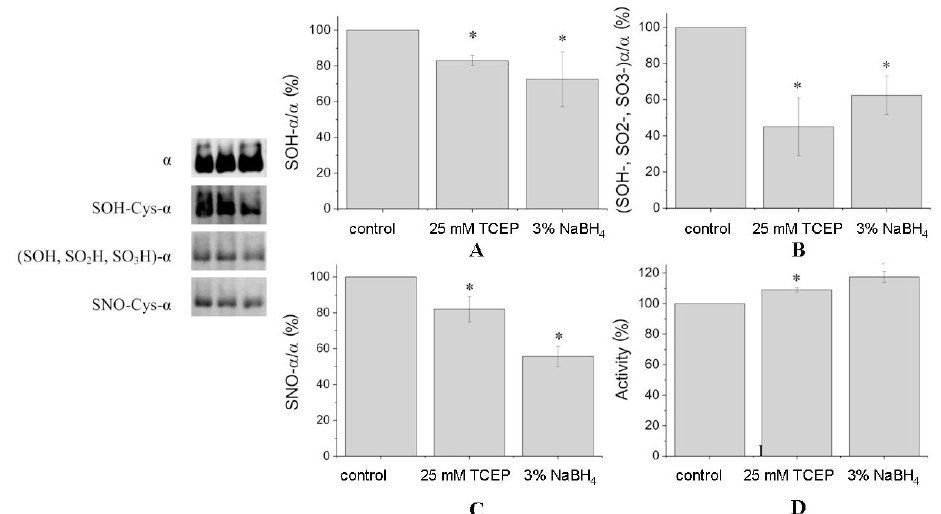
Figure 3. Chemical modifications of the α 1-subunit ( A – C ) and changes in Na,K-ATPase activity ( D ) after treatment of the enzyme by TCEP (25 mM) and sodium borohydride (3%). The Na,K-ATPase was incubated with or without reducing agent for 30 min at 37 ◦ C. The left panel depicts immunoblotting with staining by antibodies against α 1-subunit by antibodies against sulfenic acid (Cys-SOH), against all oxidized SH-groups (Cys-SOH, Cys-SO 2 H, Cys-SO 3 H), and against nitrosylated cysteine thiols (Cys-SNO). Diagrams representing densitometric analysis of immunoblots: ( A ) α 1-subunit stained using antibodies against sulfenic acid (Cys-SOH); ( B ) α 1-subunit stained using antibodies against all oxidized SH-groups (Cys-SOH, Cys-SO 2 H, Cys-SO 3 H); ( C ) α 1-subunit stained using antibodies against S -nitrosylated cysteine thiols (Cys-SNO). The bars are normalized to the α 1-subunit content stained by antibodies against α 1-subunit after stripping (number of experiments: N = 3). Data are presented as means ± SD of independent experiments. * p < 0.05.